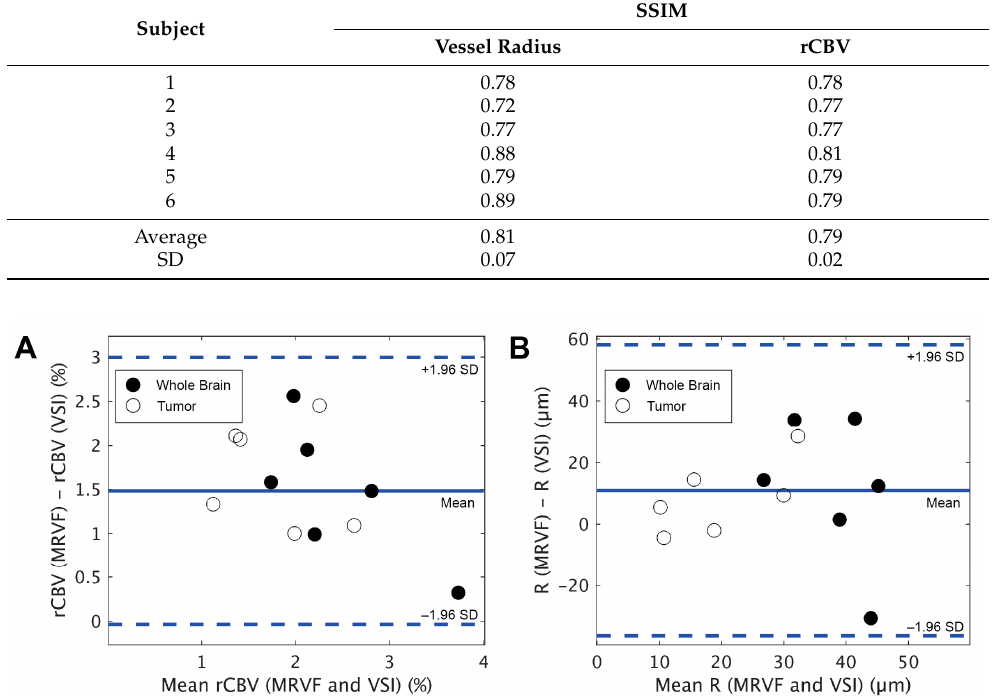
Figure 5. Bland–Altman plots resulting from the comparison of mean rCBV ( A ) and R ( B ) obtained in the whole brain and tumor regions from the MRVF and VSI techniques for the 6 patients.